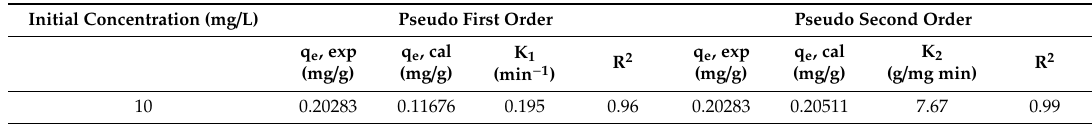
Table 1. Adsorption kinetics